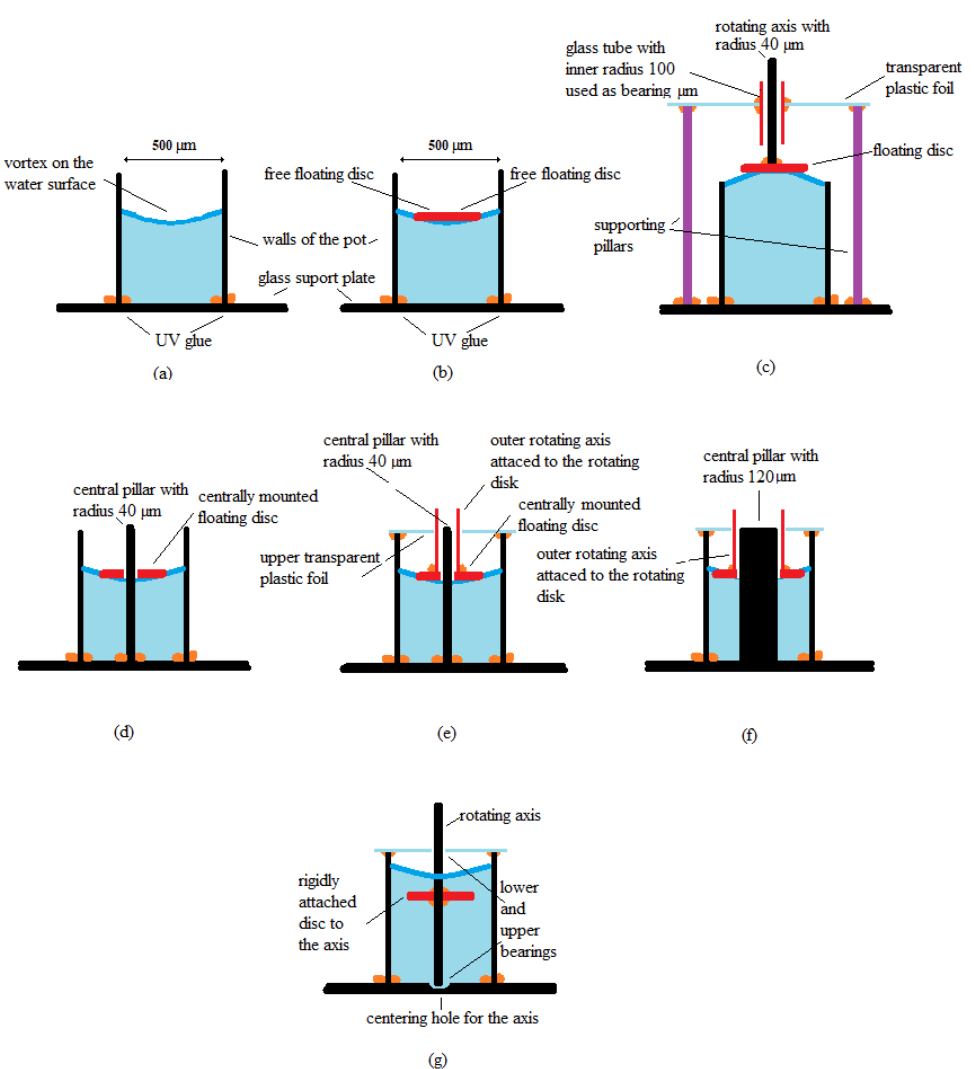
Figure 10. Seven tested types of pot-like microfluidic rotational vibrational motors with: ( a ) Vibrational pot-like mechanism. ( b ) Free floating rotating disc. ( c ) Pot-like microfluidic rotational vibrational motor with concave shape of the water surface. ( d ) Centrally mounted floating disc on the central pillar with radius 40 µ m. ( e ) Centrally mounted floating disc on the central pillar with radius 40 µ m and attached outer rotating axis. ( f ) Centrally mounted floating disc on the central pillar with radius 120 µ m and attached outer rotating axis. ( g ) Disc attached rigidly to the rotating axis.